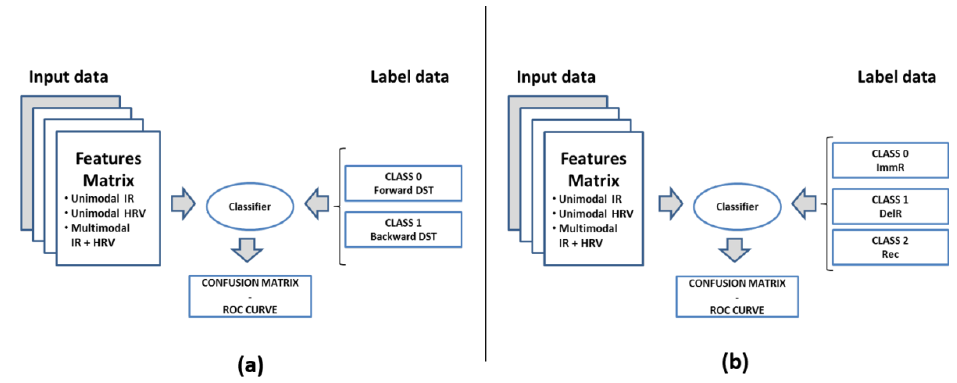
Figure 12. Scheme of classification adopted in the present work: ( a ) scheme of the two-level classification model for DST; ( b ) scheme of the three-level classification model for RAVLT.